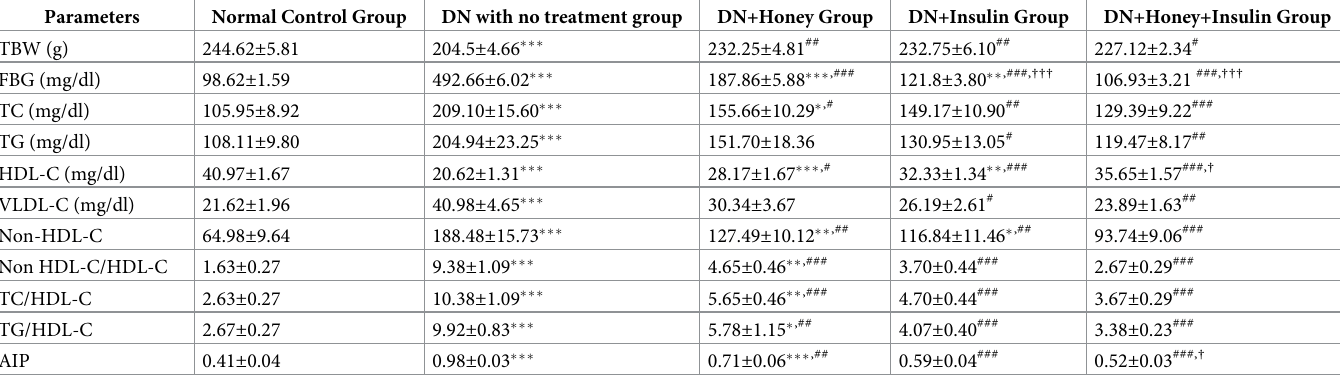
Table 2. Comparison of TBW, FBG, lipid profile and lipid risk factors in all the groups after six weeks of intervention. Parameters Normal Control Group DN with no treatment